Question: In a single sentence, describe what this figure presents.
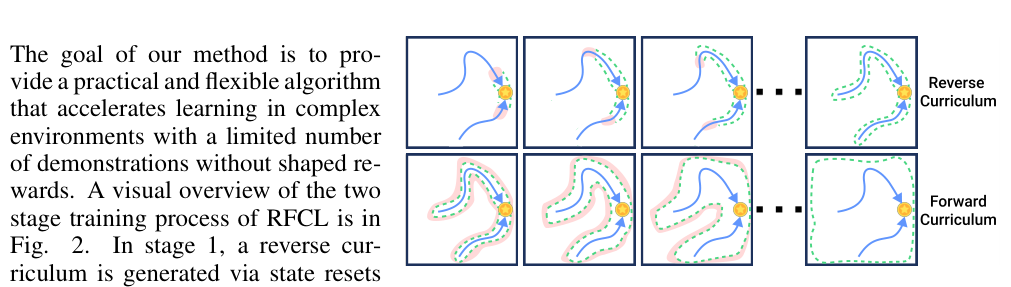
Answer: A simplfied view of the reverse and forward curriculum. The blue arrows represent the given demonstration trajectories (2 in this example), starting from an initial state and moving towards the goal marked by a gold star. The area covered by dashed green lines represent the distribution of initial states from which the pol- icy can achieve high return. The area shaded in red represents the most frequently sampled initial states during each stage of curricu- lum. From left to right represents the progression of the trained policies ability over the course of the curriculum training.